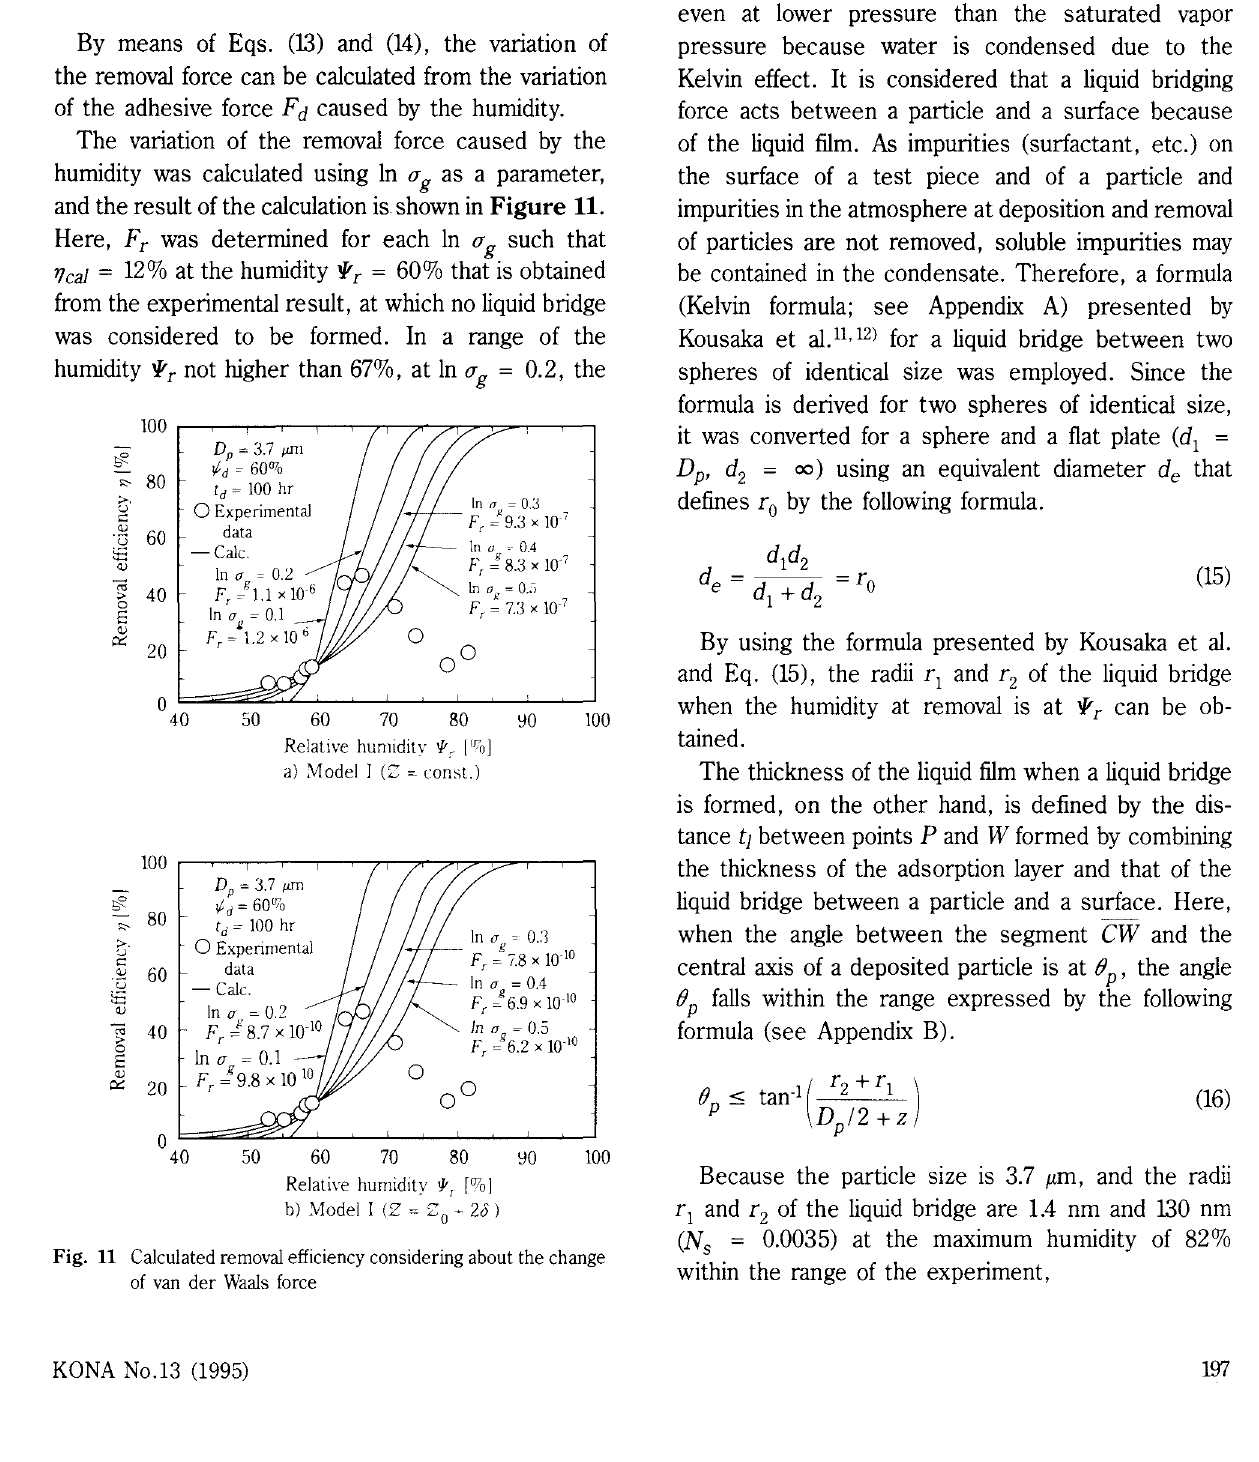
Fig. 11 Calculated removal efficiency considering about the change of van der Waals